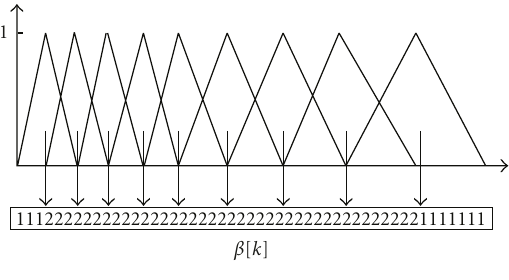
Figure 2: Schematic of β